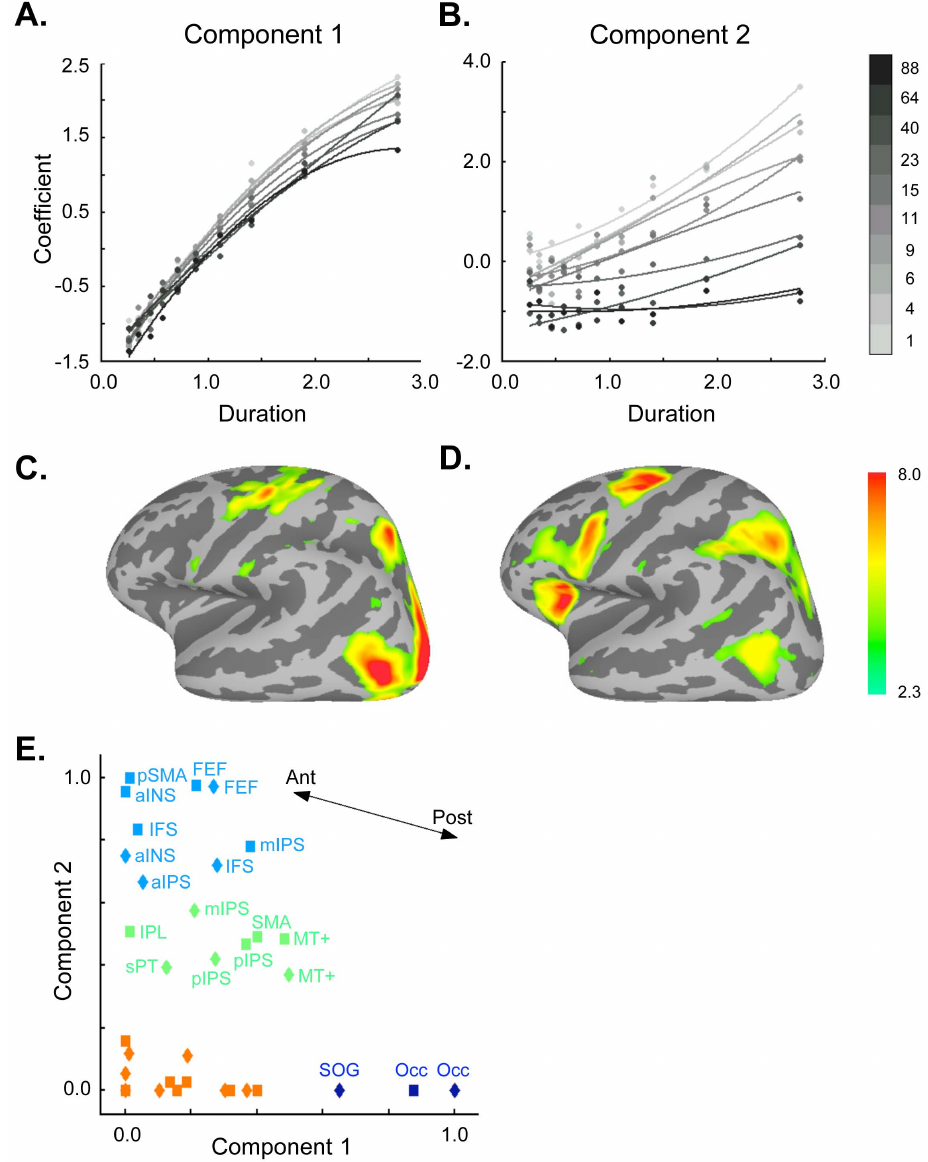
Figure 3. fMRI Results. A. Shown is the component that demonstrated the strongest effect of duration. Curves represent the best-fitting second- order polynomial. B. Shown here is the component that demonstrated both the strongest interaction between motion coherence and duration, and the strongest effect of motion coherence. C. The spatial map associated with component 1. D. The spatial map associated with component 2. The color bar represents Z scores and applies to both surfaces. E. Forty-one regions demonstrating a main effect of task were evaluated for their sensitivity to component 1 and component 2, each normalized to their respective maxima (Table 1). K-means clustering defined related regions within the component 1– component 2 space, where the value of each component for a given ROI was normalized to the maximum value of that component across all ROIs. Progressively more anterior regions showed less sensitivity to component 1, and more sensitivity to component 2, as indicated by the arrow. Labels are shown for ROIs demonstrating stronger component values (cyan, green, and navy clusters); the large number of regions that were minimally influenced by these factors (orange cluster) can be found, along with all labels and component values, in Table 1. Left- sided regions are represented by squares, right-sided regions by